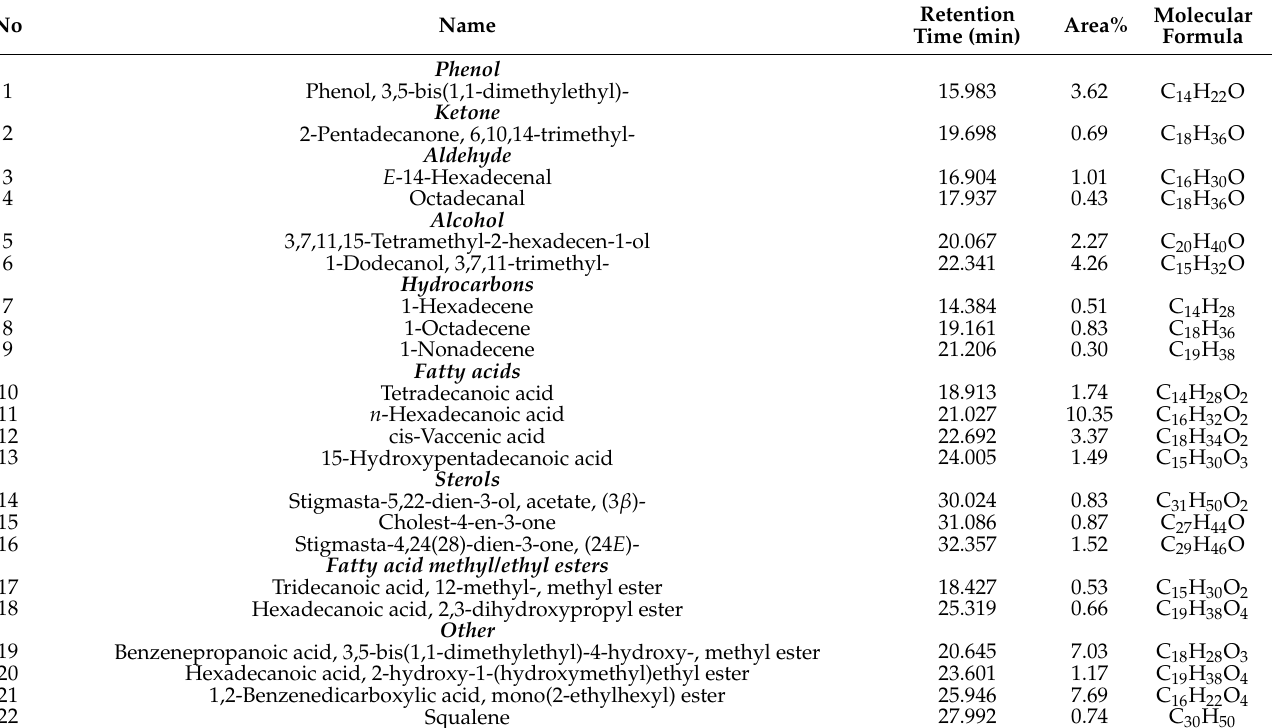
Table 7. Metabolite profile of S. Polycystum